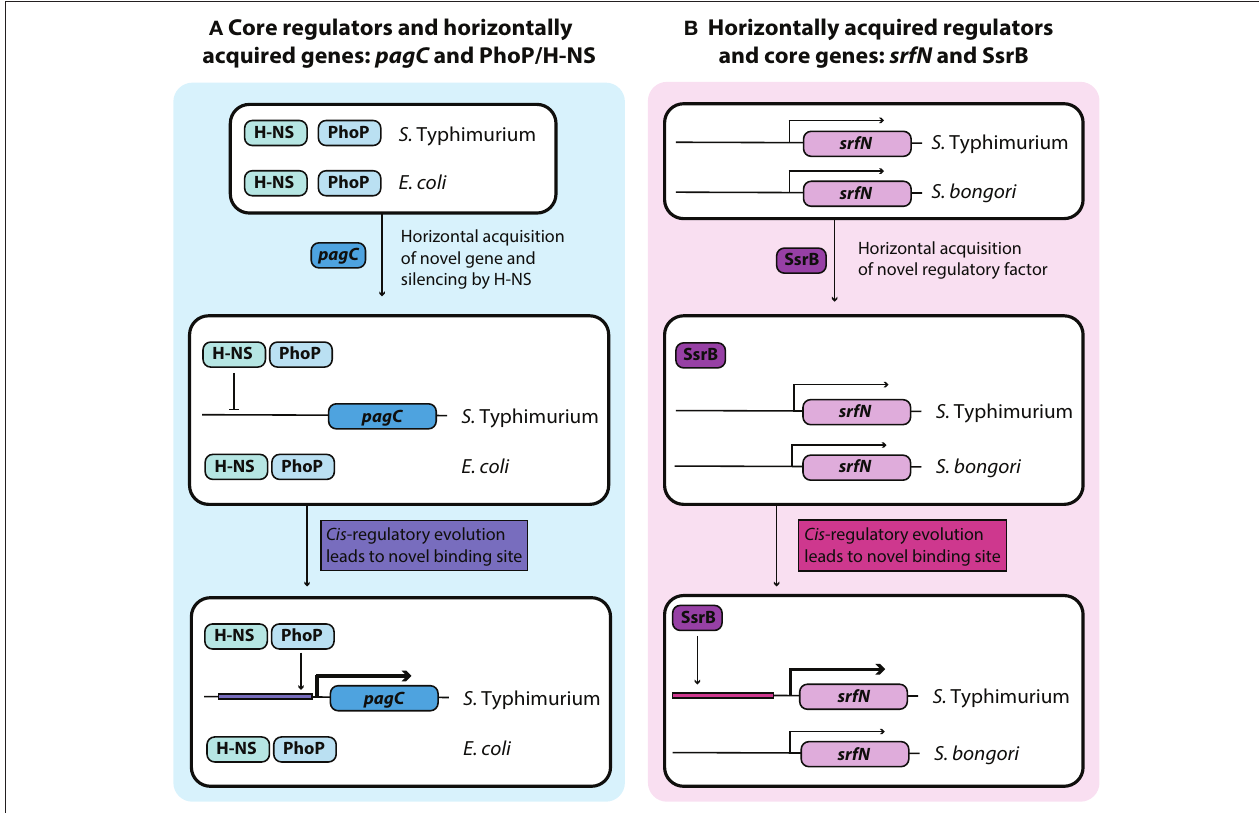
FIGURE 2 | Development of novel regulatory pathways through transcriptional rewiring. (A) Horizontally acquired genes in Salmonella are silenced by H-NS, and cis -regulatory elements can undergo mutations to acquire binding sites that bring these genes under the control of a core virulence regulator such as PhoP. This counter-silencing allows for activation of virulence relevant horizontally acquired genes like pagC in infection relevant conditions. (B) Acquisition of the transcriptional regulator SsrB in Salmonella Typhimurium led to cis -regulatory evolution of core genes that allow them to come under the regulatory control of SsrB. This regulatory rewiring of core genes fine-tunes their expression under infection conditions with other SsrB regulated